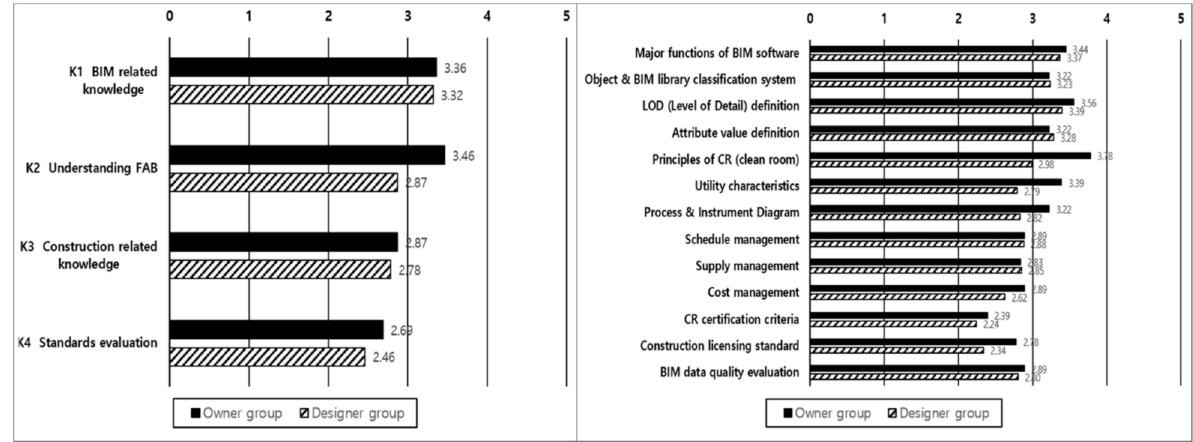
Figure 5. Current competency level of ‘Knowledge’ domain competencies.